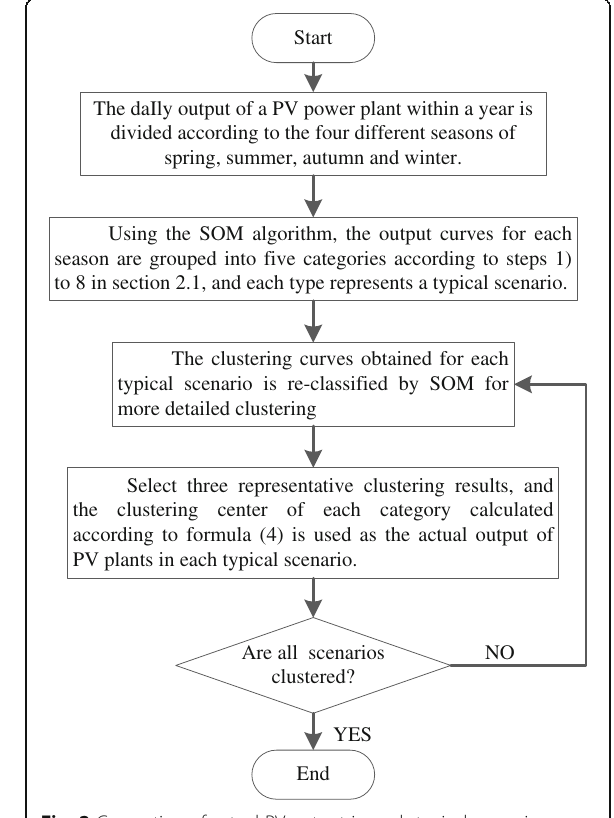
Fig. 2 Generation of actual PV output in each typical